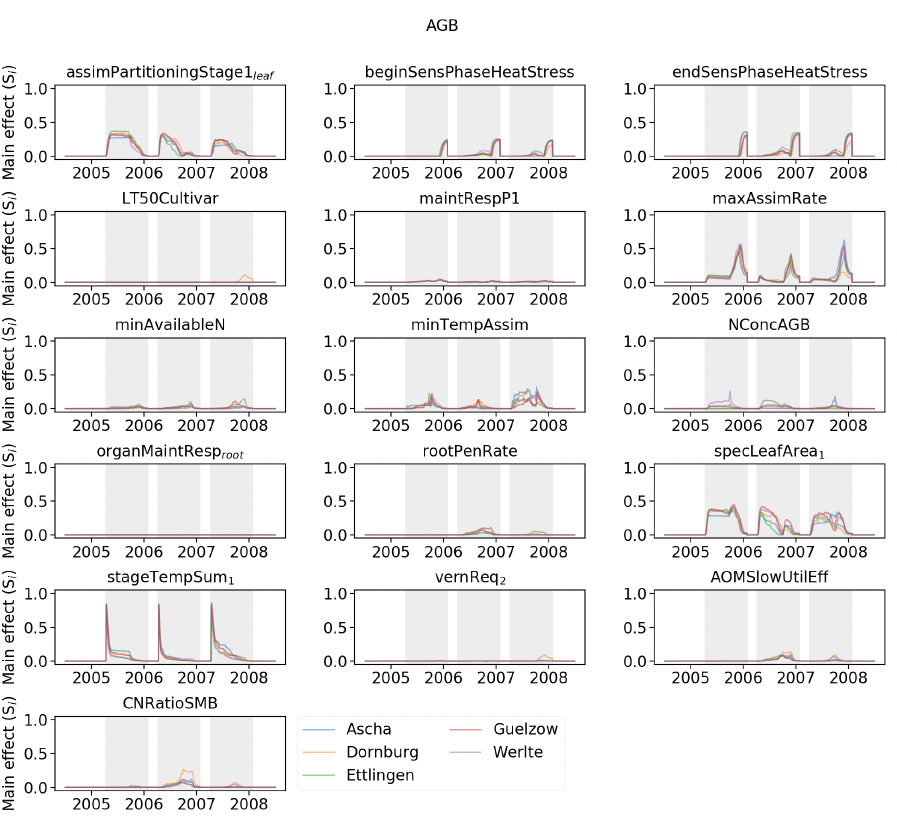
Figure A2. Daily S i values calculated using the extended FAST method for AGB differentiated among the different